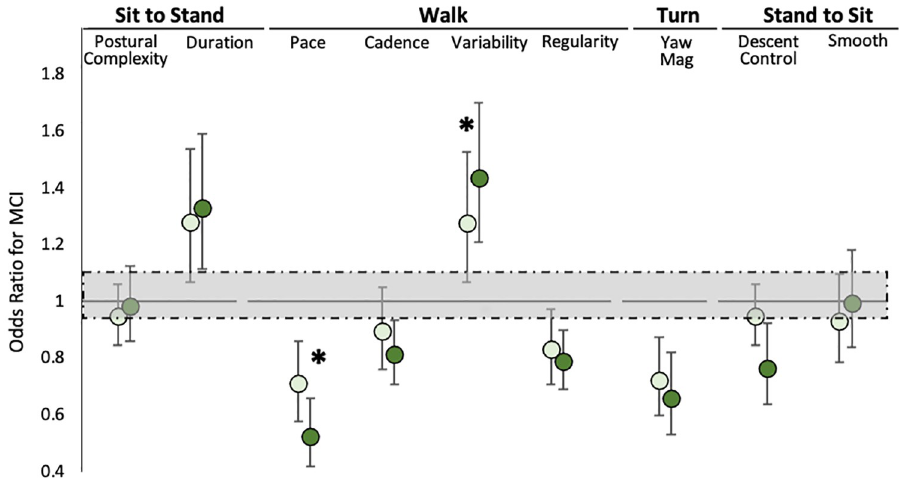
Fig 1. Quantitative TUG vs. MCI. Odds ratios and 95% confidence intervals for MCI based on individual mobility performance scores during normal (light green) and dual-task (dark green) Timed Up and Go (TUG). All models were adjusted for age, sex, race (Black versus White), and education. Statistically significant associations ( p < .005) do not touch the shaded box. � indicates associations that significantly differ across conditions.